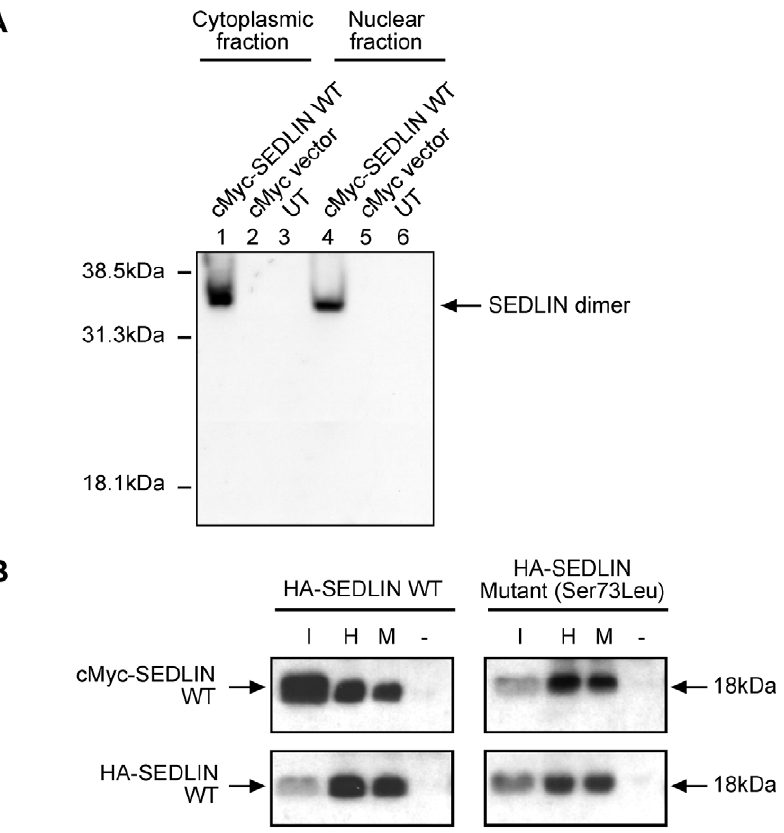
Figure 6. SEDLIN forms homodimers. (A) Western blot analysis, using a monoclonal anti-cMyc antibody, of cell lysates obtained from COS7 cells transfected with cMyc-SEDLIN or cMyc vector alone, and resolved by continuous non-denaturing PAGE; lanes 1-3, cytoplasmic fractions; lanes 4–6, nuclear fractions; lane 1 and 4, transfected with cMyc-SEDLIN wild-type (WT) construct; lanes 2 and 5, transfected with cMyc vector alone; and lanes 3 and 6, untransfected (UT) cells. cMyc-SEDLIN, an 18 kDa protein (Figures 3 and 4) appeared as a 36 kDa protein on non-denaturing PAGE of cytoplasmic and nuclear fractions obtained from COS7 cells transfected with the cMyc-SEDLIN wild-type (WT) construct, consistent with homodimerization of SEDLIN protein. (B) Co-immunoprecipitation of wild-type (WT) cMyc-SEDLIN with wild-type or mutant HA-SEDLINs (data for mutant Ser73Leu, shown). Anti-cMyc antibody co-immunoprecipitated wild-type HA-SEDLIN in the presence of cMyc-SEDLIN (lane M) and anti-HA antibody co-immunoprecipitated cMyc- SEDLIN in the presence of HA-SEDLIN (lane H); in the absence of the anti-cMyc or anti-HA antibodies SEDLIN was not immunoprecipitated (lane -). Five percent of the lysate (input (I)) that was used for the immunoprecipitation was electrophoresed in parallel with immunoprecipitated lysates. Similar results were observed for the other SEDLIN mutants (Asp47Tyr, Phe83Ser, Val130Asp and Gln131Stop) (data not